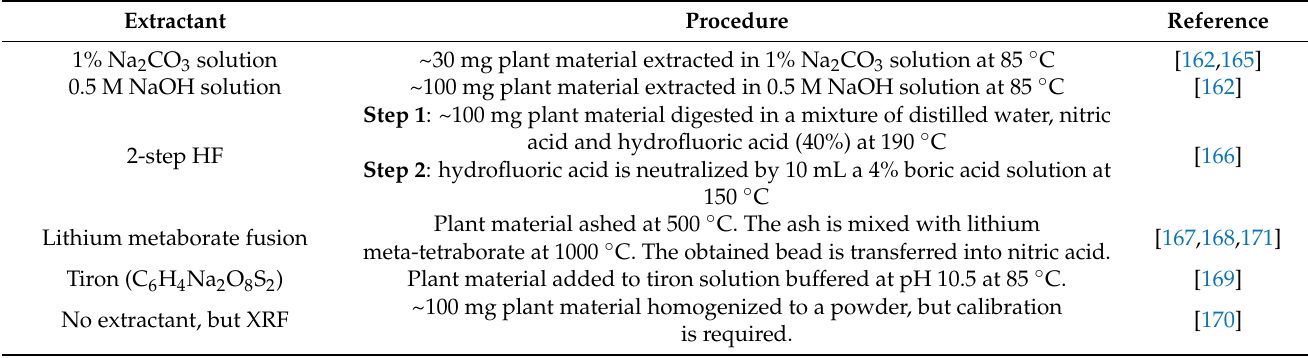
Table 1. Summary of main plant Si extraction and measurement